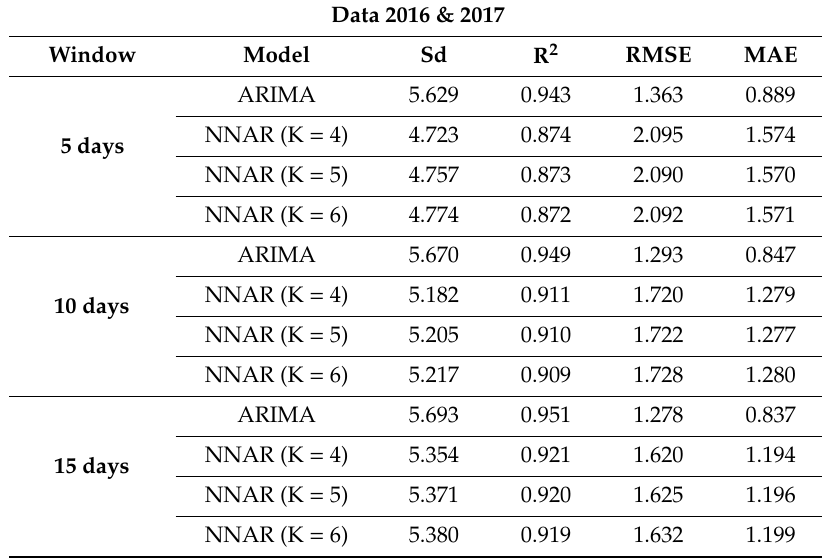
Table 2. Forecasting results using data from 2016 and 2017: Standard deviation, determination coe ffi cient, root mean square error and mean absolute error for ARIMA and